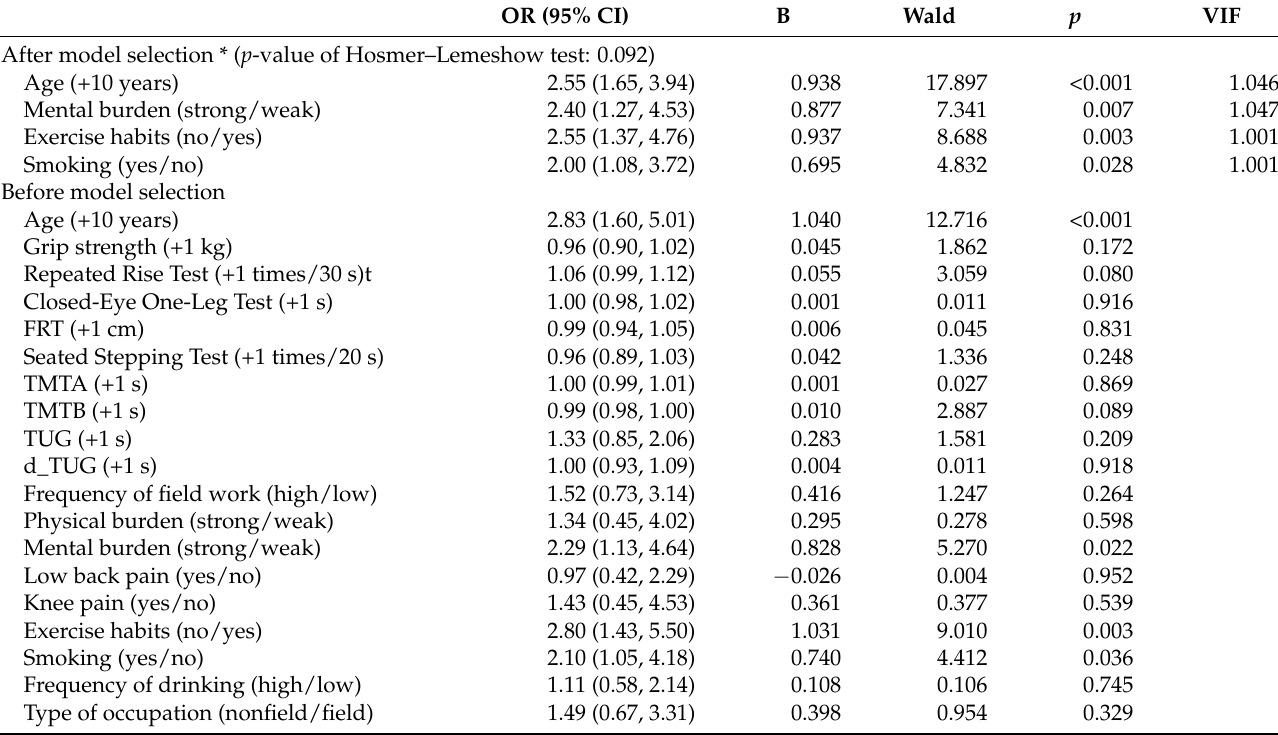
Table 6. Odds ratios and 95% confidence intervals for falling after and before model selection in men. OR (95% CI) B Wald VIF